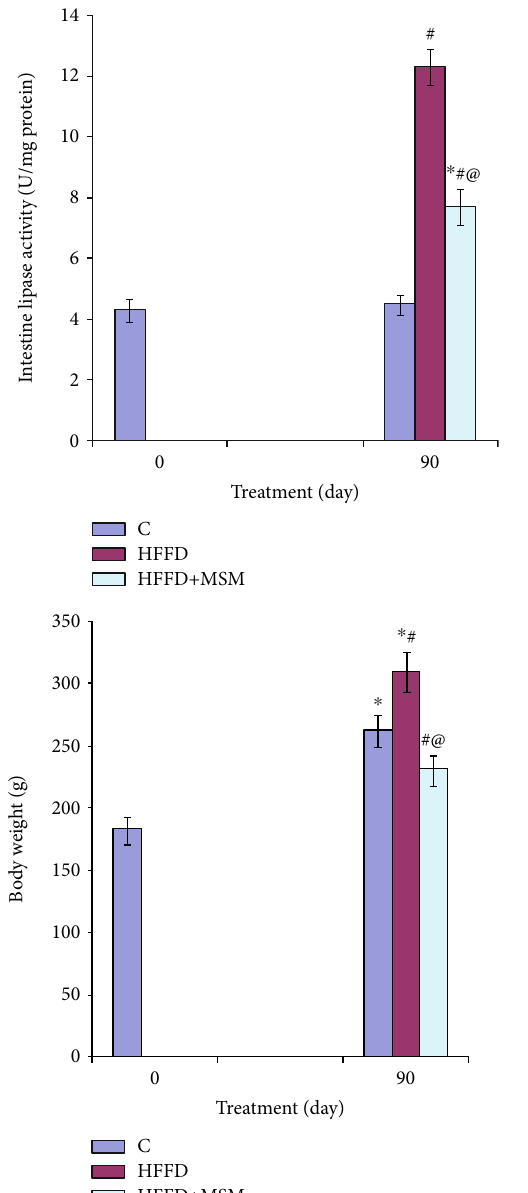
Figure 4: Intestinal α -amylase activity and blood glucose level in HFFD rats treated with MSM. ∗ P < 0 : 05 signi fi cant di ff erences compared to controls (0 day). # P < 0 : 05 signi fi cant di ff erences compared to controls (90 days). @ P < 0 : 05 signi fi cant di ff erences compared to HFFD